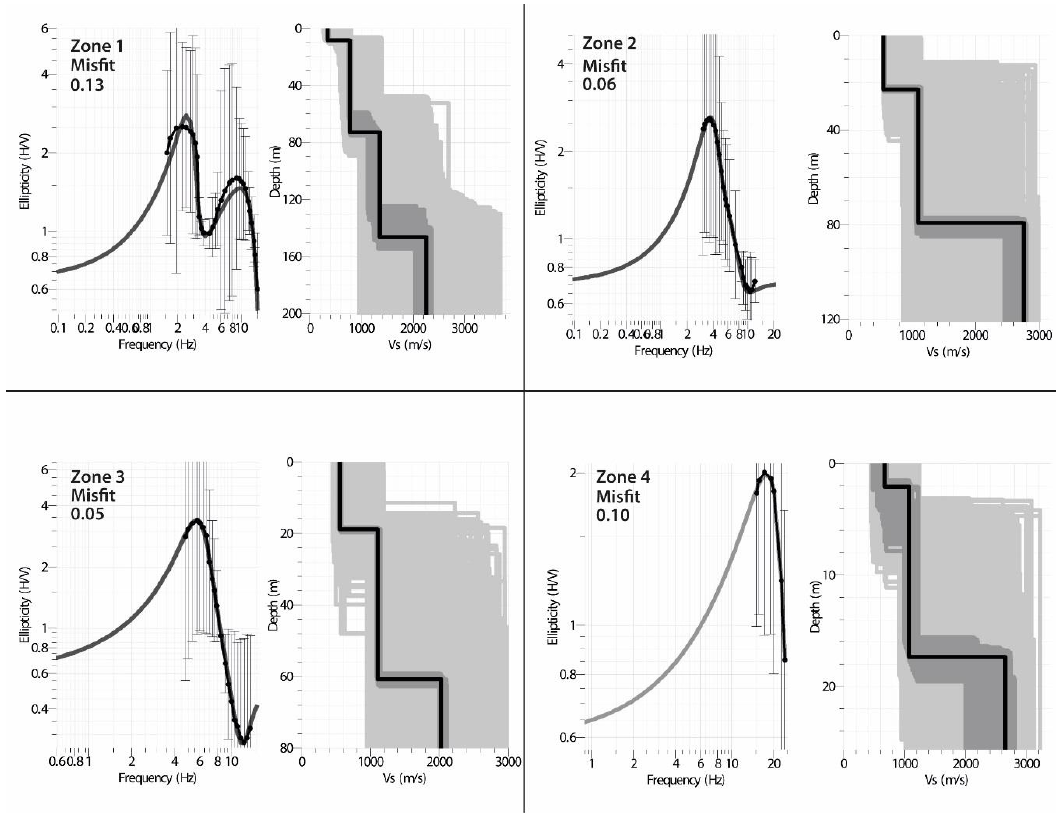
Figure 8. Examples of the estimated shear-wave velocity profiles for each zone. The left panels represent the computed fundamental mode of Rayleigh wave ellipticity curve (dark grey curve), and the inverted part of the calculated Rayleigh wave ellipticity (black dotted curve) for each zone linked via misfit values. The right panels represent the obtained shear-wave velocity models. The model in black corresponds to the one with the minimum misfit, while dark grey corresponds to models with misfit +10%. The rest of the generated models are represented in light grey.